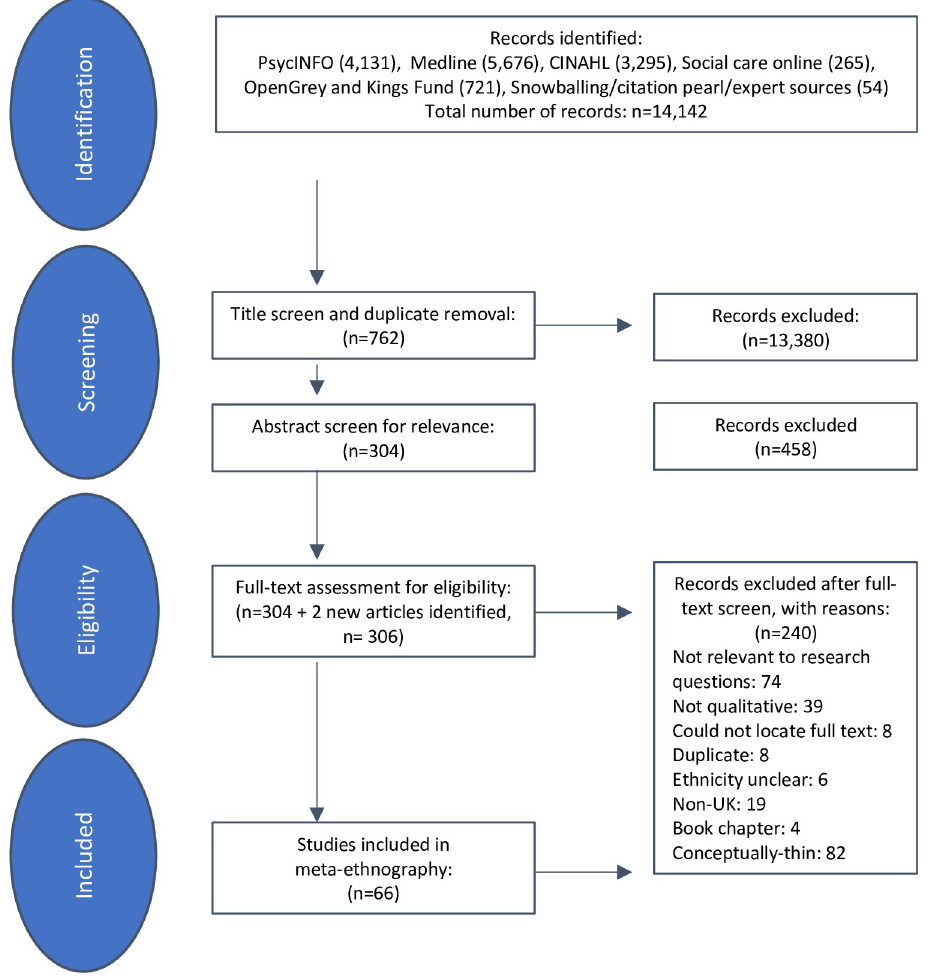
Fig 1. Outcome of study